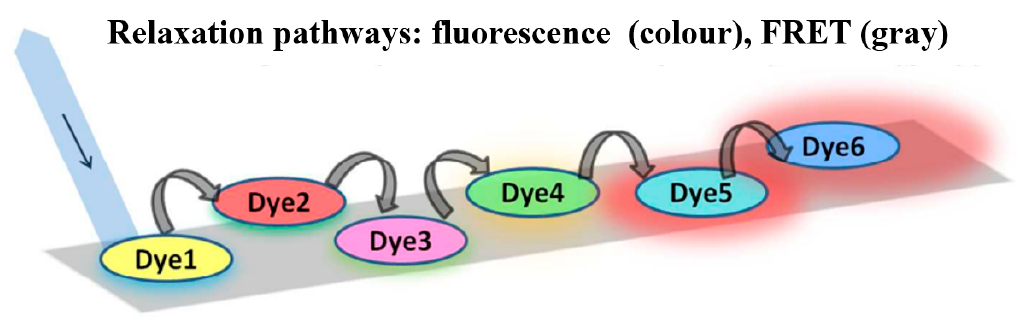
Figure 44. The possible relaxation process of the six dyes [166].